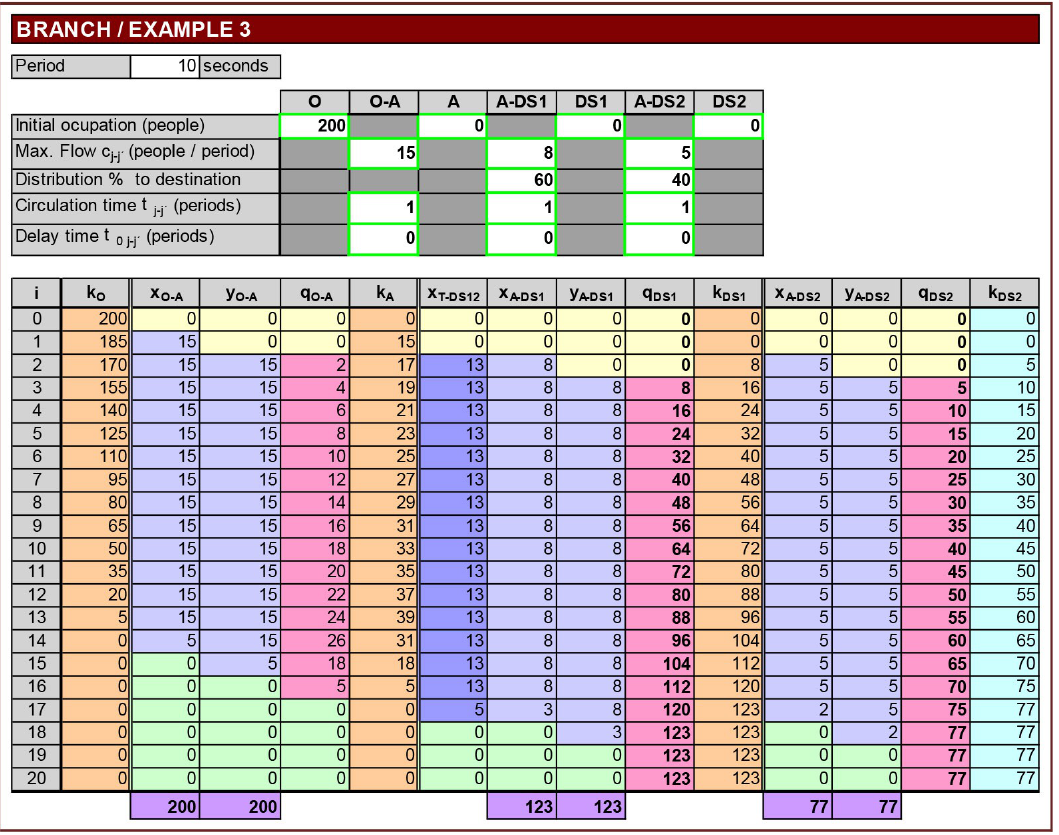
Figure 25. Example of branch result